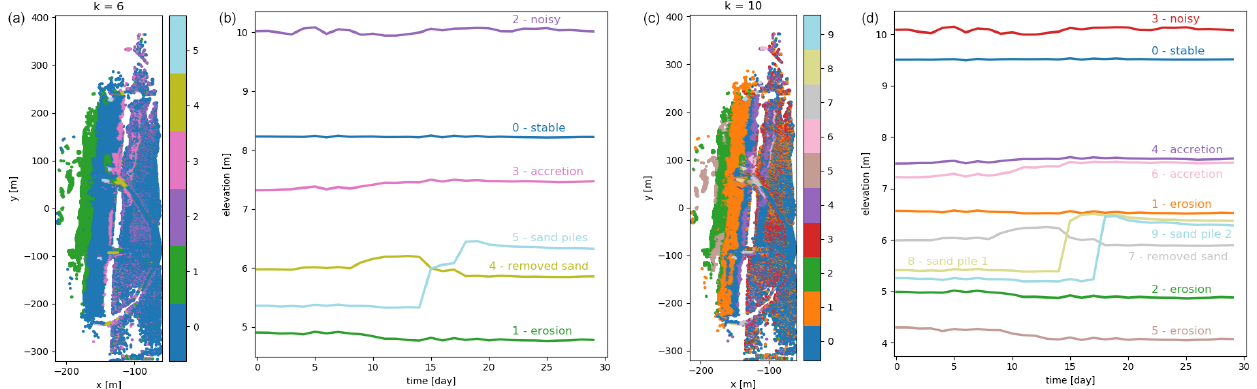
Figure 7. (a, c) Overview of the entire observation area divided into clusters using the k -means algorithm with k = 6 (a) and k = 10 (c) . (b, d) Corresponding cluster centroids for each of the clusters are shown in panels (a) and (c) , respectively. By using a larger number of clusters k , more processes become visible, for example, two sand piles ( a, b : cluster 5) created on two different days ( c, d : clusters 8 and 9). Also the large stable areas ( a, b : cluster 0) and slowly accreting areas ( a, b : cluster 3) are split up into several clusters: a slightly eroding area ( c, d : cluster 3) is split up from the stable part, and the accreting area is split into two ( c, d : cluster 4 and cluster 6). Table 2. Summary of comparison of k -means algorithm, agglomerative clustering (AGG) and DBSCAN algorithm. k -means algorithm AGG DBSCAN Entire observation area No. of